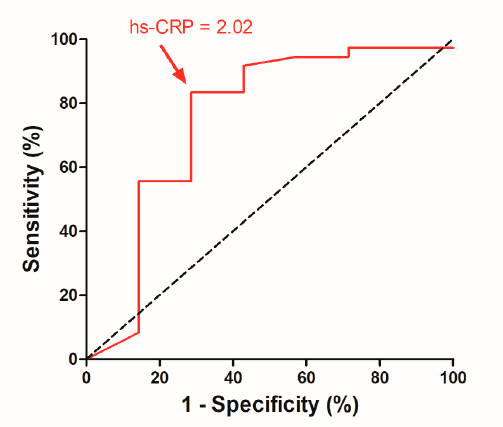
Figure 4. Receiver operating characteristic curve analysis for preoperative hs-CRP in predicting postoperative depressive status. A cutoff value of preoperative hs-CRP value at 2.02 mg/L was obtained to have optimal sensitivity and specificity. hs-CRP: high-sensitivity C-reactive protein. Table 3. Preoperative serum hs-CRP level according to postoperative depressive status.